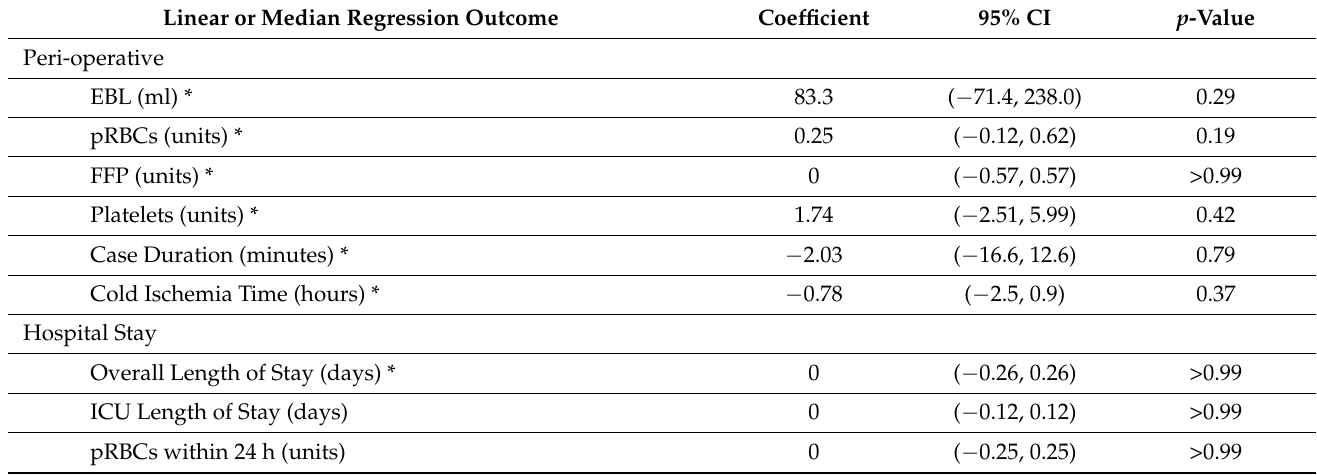
Table 4. Unadjusted Regression Models for Outcomes vs. Total Number of LRTs